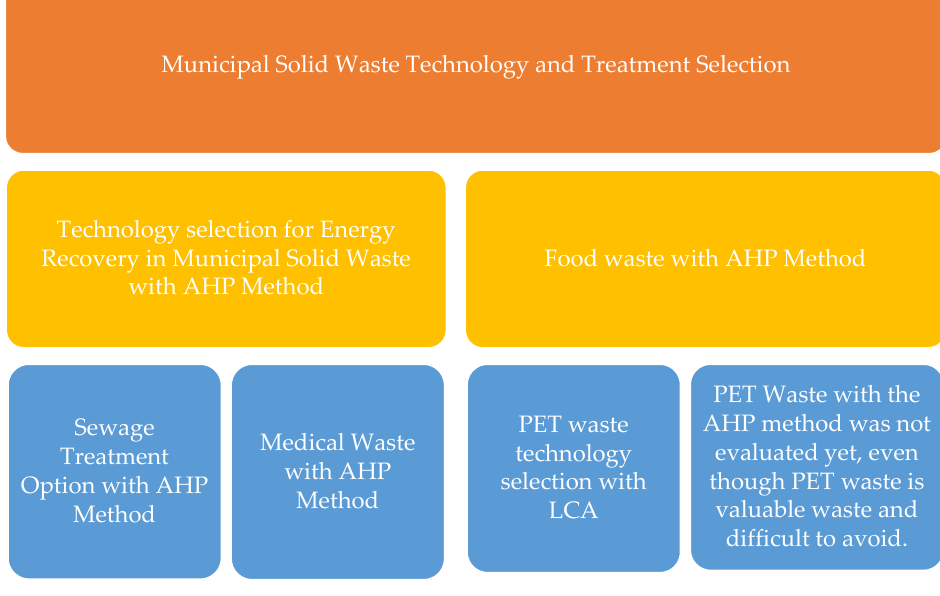
Figure 1. Literature review summary.